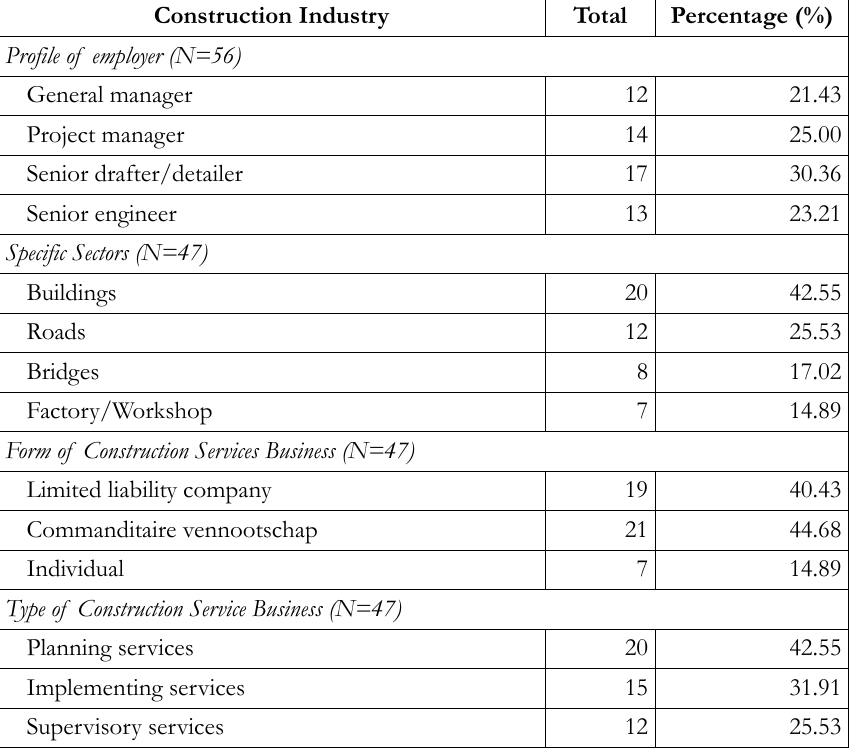
Table 1. Profiles of construction companies and research